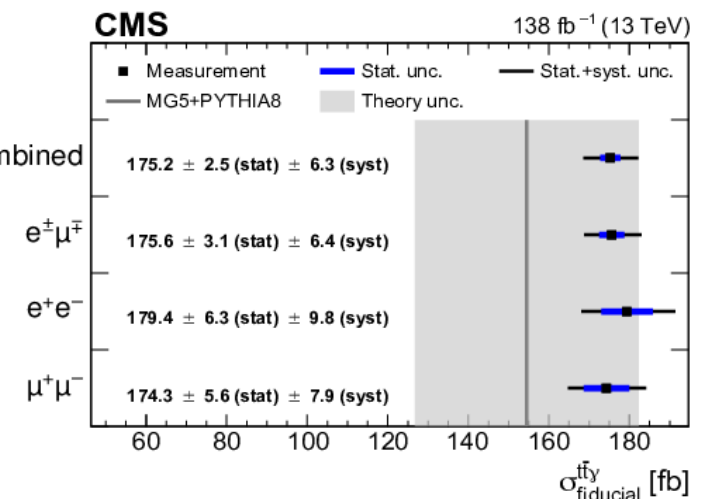
Figure 19. Inclusive t¯t γ production cross-section measurements by CMS in the dilepton channel [48]. Results are also shown for both the combined measurement and the breakdown for the individual dilepton